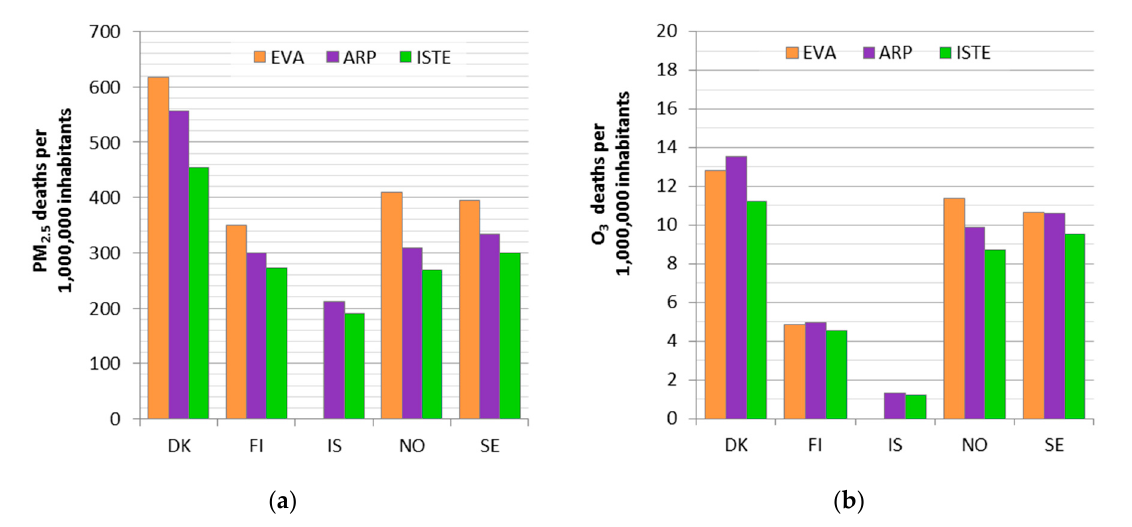
Figure 2. Deaths attributable to ( a ) PM 2.5 and ( b ) O 3 exposures in the Nordic countries per million inhabitants. The results for Economic Valuation of Air Pollution (EVA) tool include acute deaths in addition to chronic deaths for PM 2.5 .